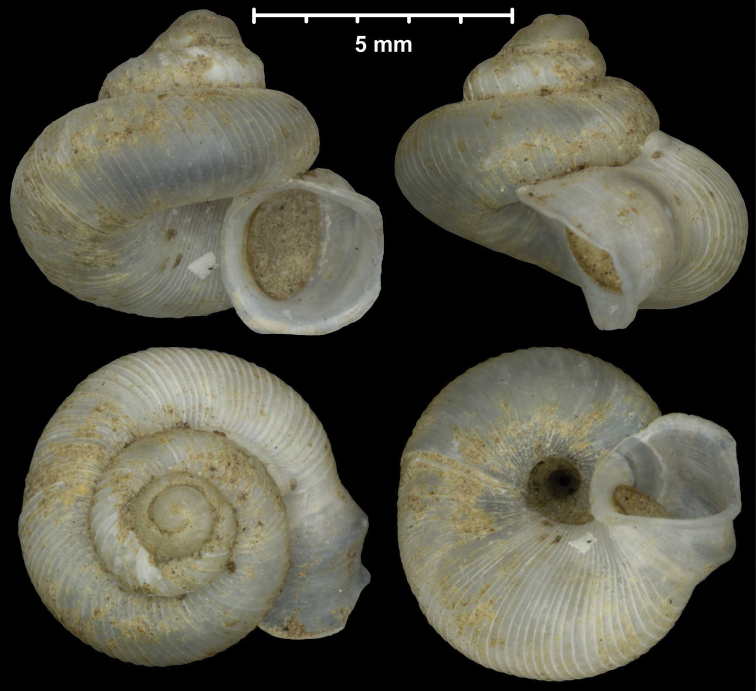
Metalycaeus
(?)
libonensis (Chen, Li & Luo, 2003), holotype. Photographs: Kaibaryer Meng.